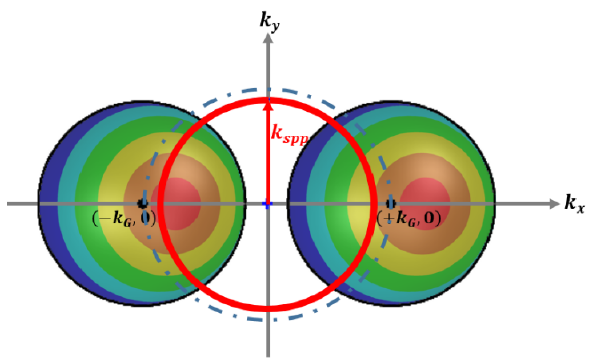
Figure 8. The Mie scattering k vector modulated by the reciprocal k G vector of a circular grating. The colorful Mie scattering vector span is moving around the dotted circular outline with radius k G . The red circular k spp boundary could intersect with the colorful Mie scatting area while the color area is moving around the dotted line.